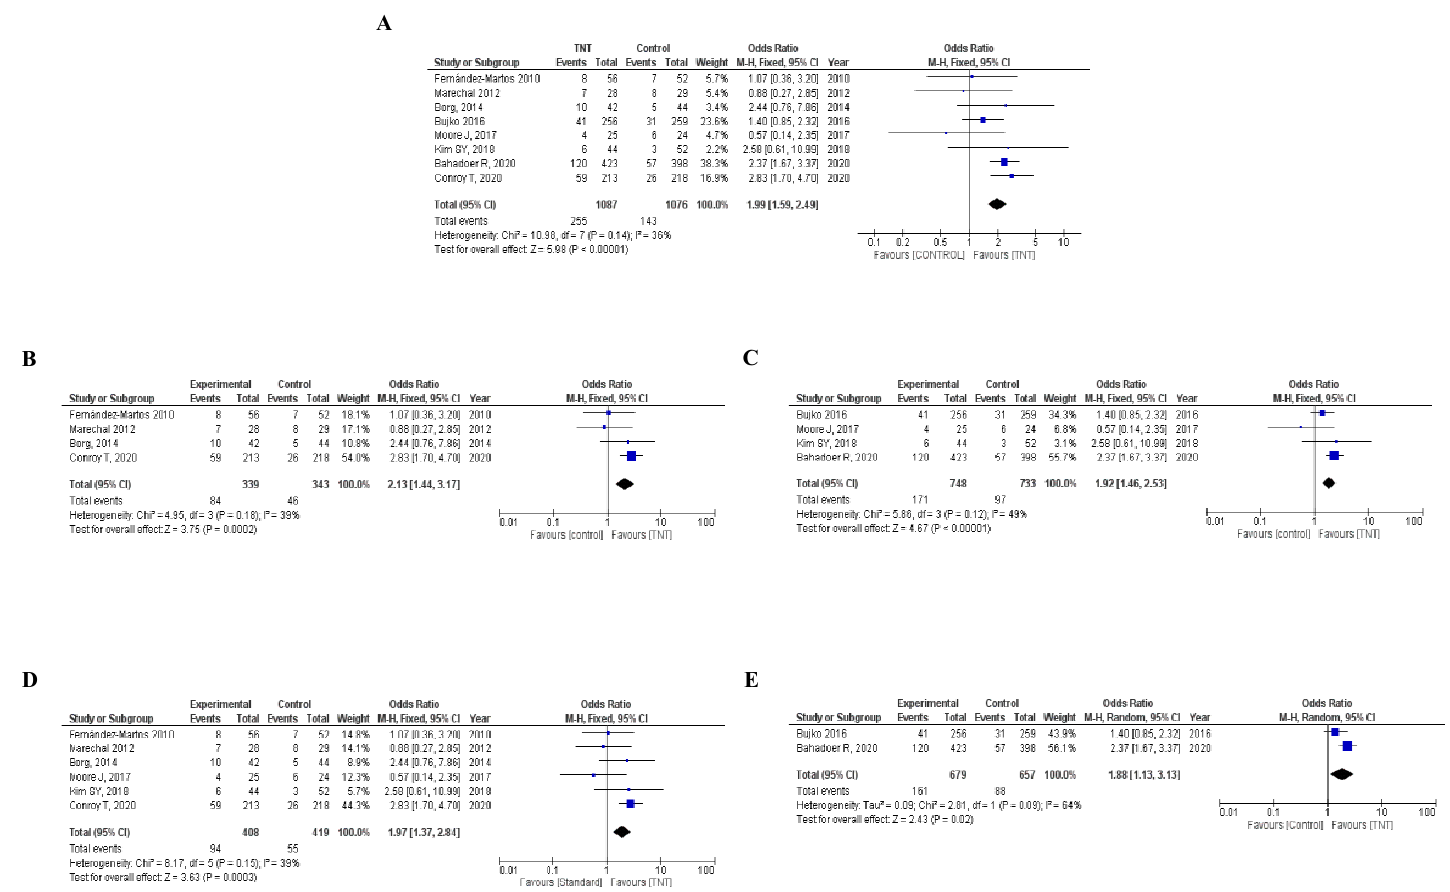
Figure 2. ( A ) Forest plot for pathologic complete response of TNT vs. standard treatment. Forest plot for pathologic complete response of TNT vs. standard treatment using: ( B ) induction chemotherapy in the experimental arm; ( C ) consolidation chemotherapy in the experimental arm; ( D ) long-course chemo-radiotherapy in the experimental arm; ( E ) short-course radiotherapy in the experimental arm. CI: confidence interval, OR: odd ratio, TNT: total neoadjuvant